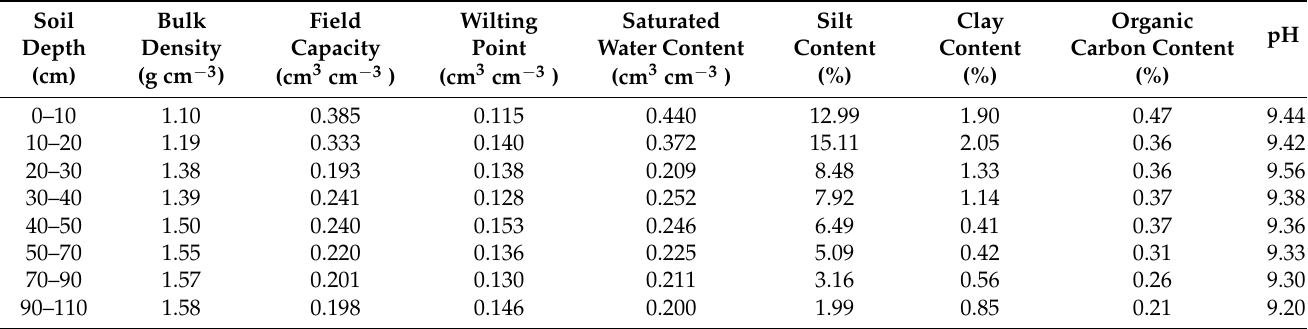
Table 1. Soil profile data collected in 2014 spring and used as initial condition input of the